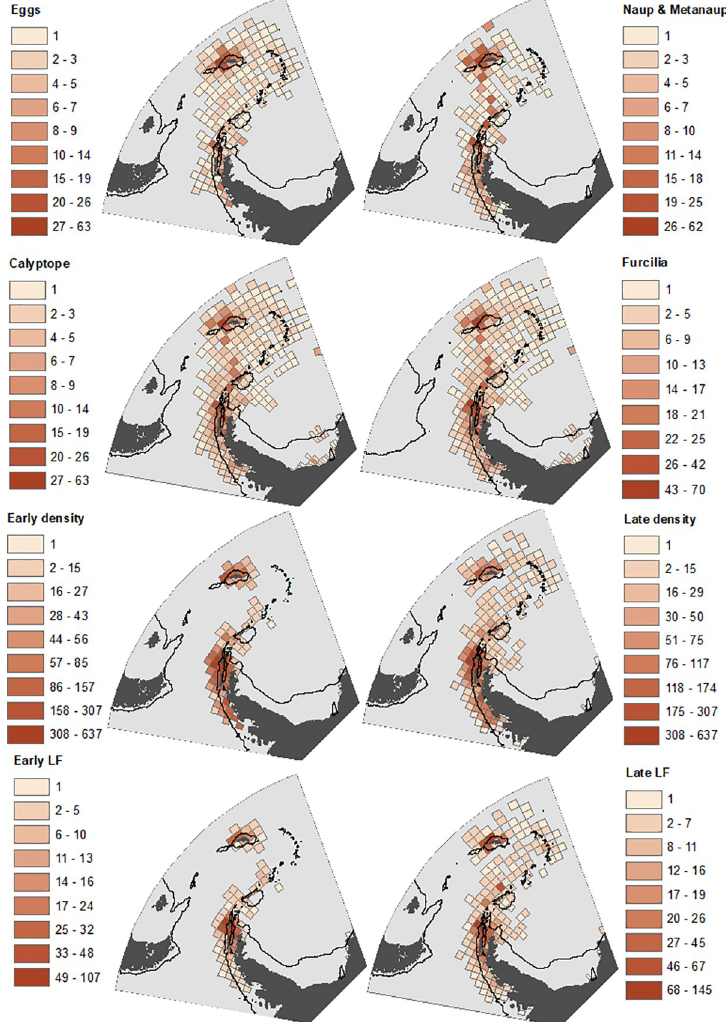
Fig 2. Density of sampling coverage for each krill life stage. Natural breaks have been used for the scale division of number of stations per grid cell: note the difference in scale between life stages. Eggs, nauplii, calyptopes, and furcilia are depicted here and in the rest of this paper only for the late (January to May inclusive) part of the survey season due to lack of stations and low abundances in the early part of the season. Sampling intensity plots for combined juveniles and adults male and female density and length-frequency (LF) are shown both for the “early” (October to December inclusive) and “late” (January to May inclusive) parts of the survey season. Both the 1000m isobath (continental shelf edge; solid black line) and the Antarctic Polar Front (dashed black line) are